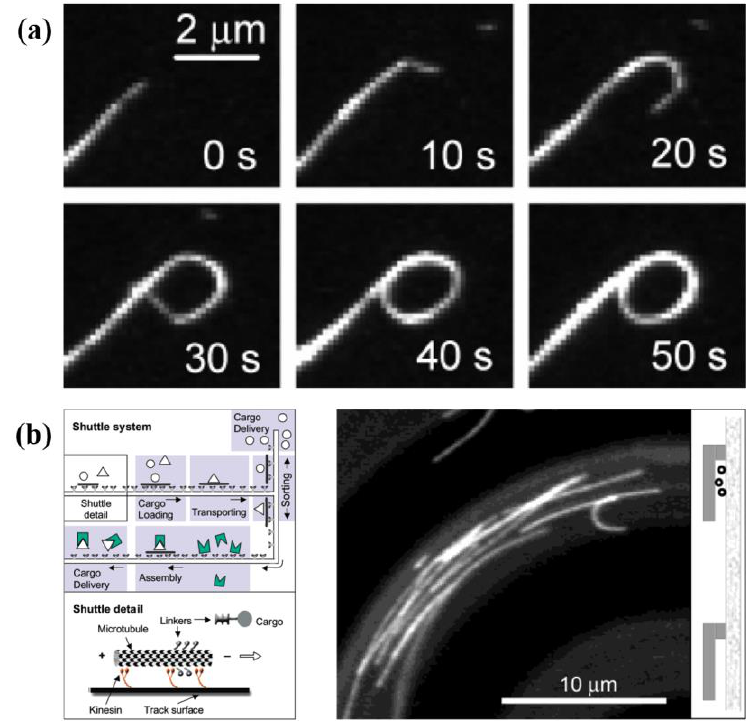
Figure 3. RCF-based bioshuttle. ( a ) Formation of a nanospool structure. Reprinted with permission from Reference [33], Copyright 2005, American Chemical Society. ( b ) The schematic of RCF-based bioshuttle. Reprinted with permission from Reference [34], Copyright 2003, American Chemical Society.